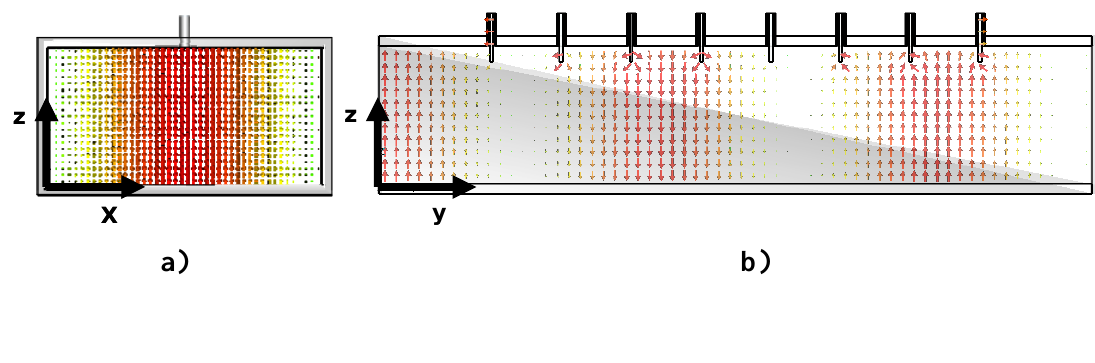
Figure 4. Electric field distribution for TE cross section. (b) Along the propagating